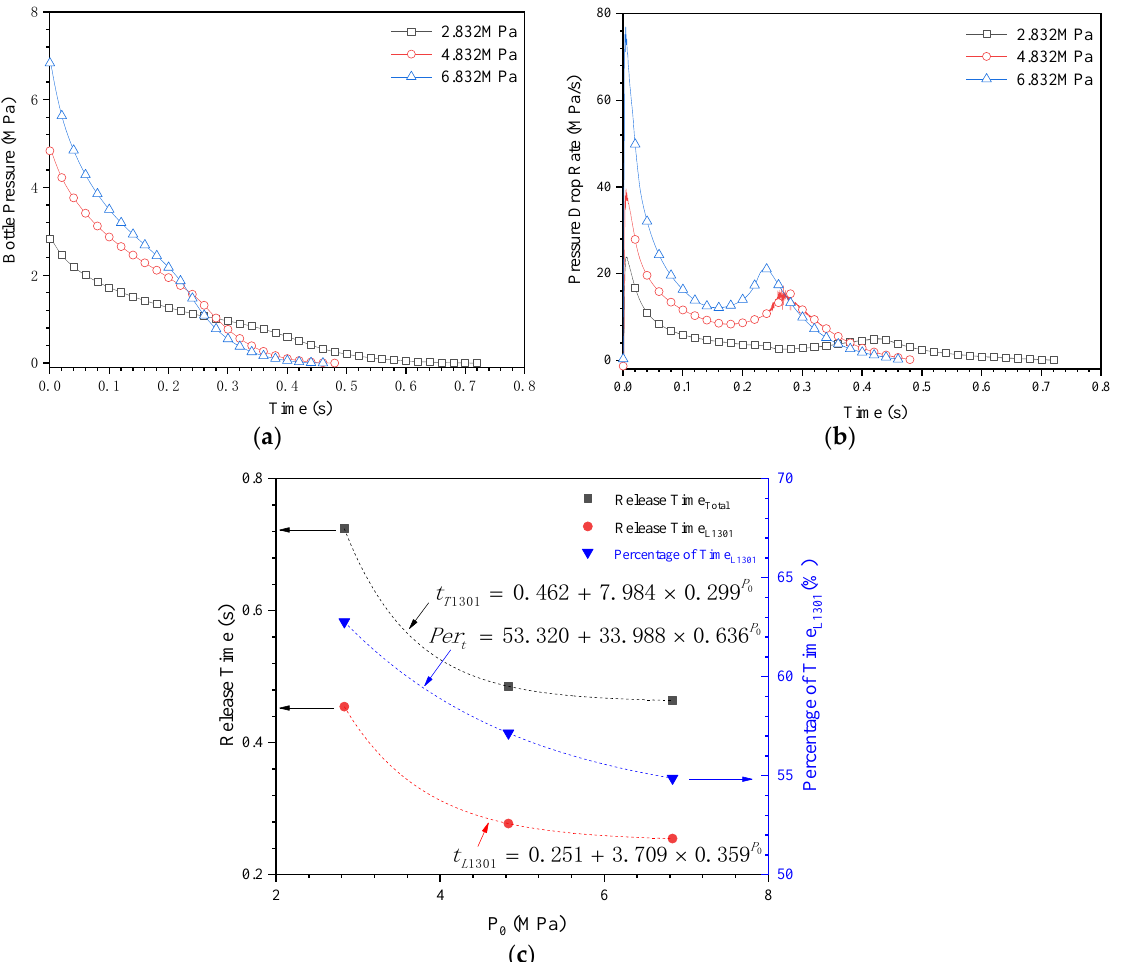
Figure 8. Bottle pressure and release time under different filling pressures: ( a ) bottle pressures; ( b ) bottle pressure-drop rates; ( c ) release times and percentages of liquid-release duration.